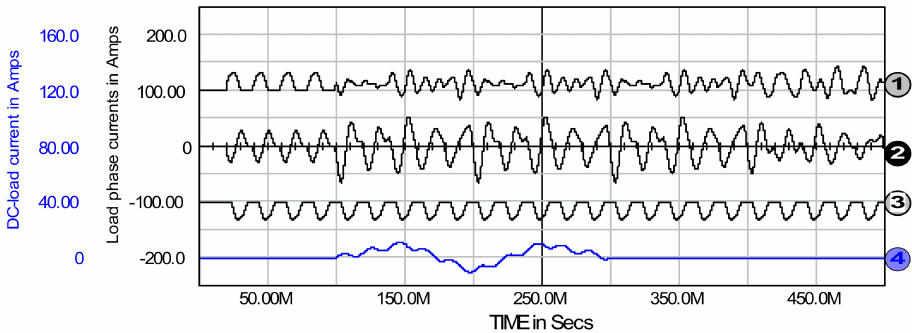
Figure 17. AC side load phase currents: waveforms 1–3, Y scale is 50 A/div for these currents; and DC side load current: waveform 4, Y scale is 20 A/div.